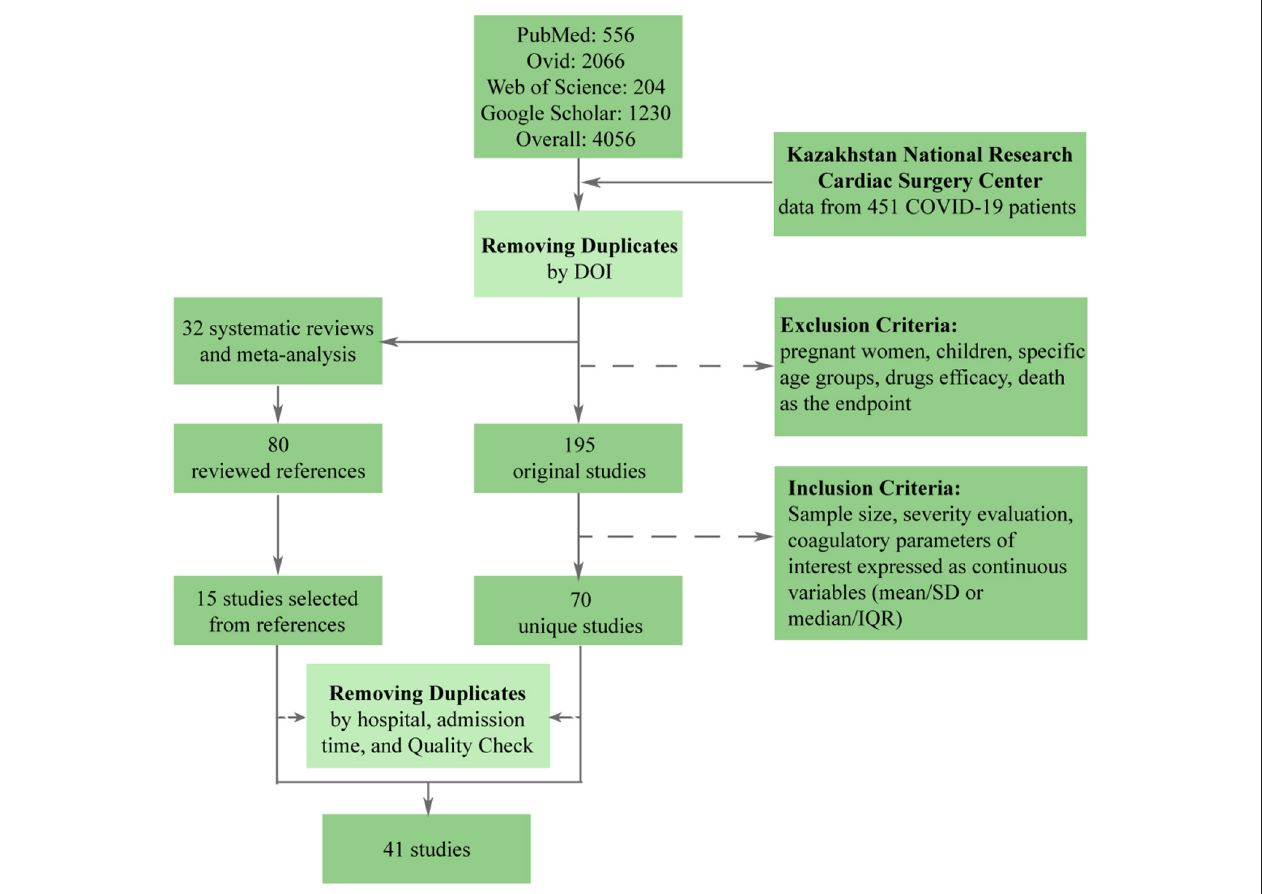
FIGURE 1 | Flow diagram illustrating the process of data